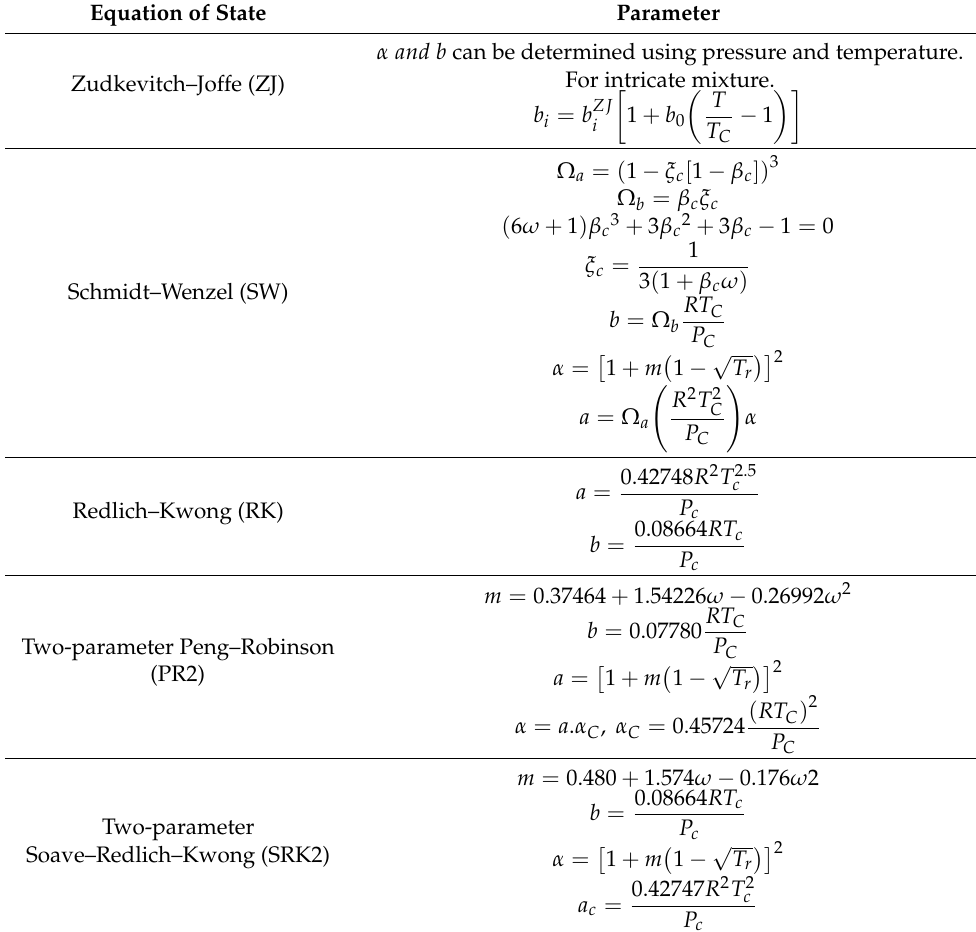
Table 6. Parameters of the EOSs employed in this research work